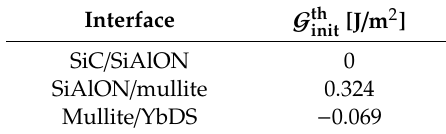
Table 10. G th for T / EBC model with h SA = 5 µ m and h Mu = 20 µ m. init Table 10. 𝒢 (cid:2919)(cid:2924)(cid:2919)(cid:2930)(cid:2930)(cid:2918) for T/EBC model with h SA = 5 µm and h Mu = 20 µm.